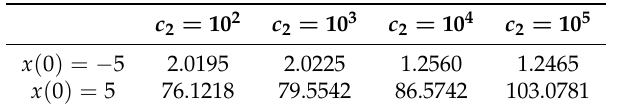
50 ∑ (cid:96) e ( x ( n ) , u ( n )) of EMPC of Equation (10). n = 0